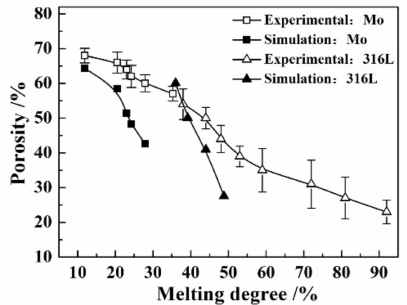
Figure 10. Simulation value with slipping